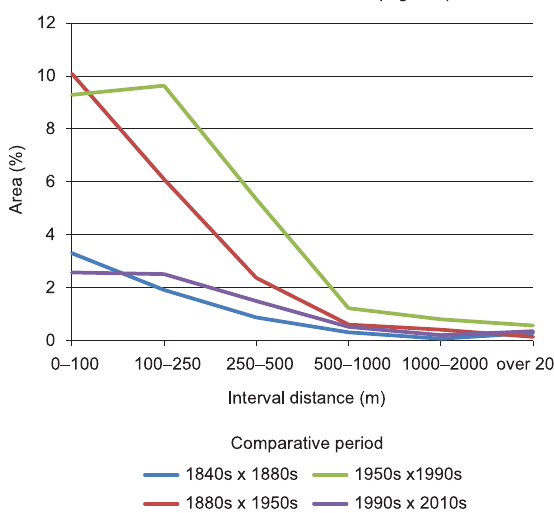
Fig. 10. Urbanisation and other anthropogenic processes in the Hodonín region at various distances from existing